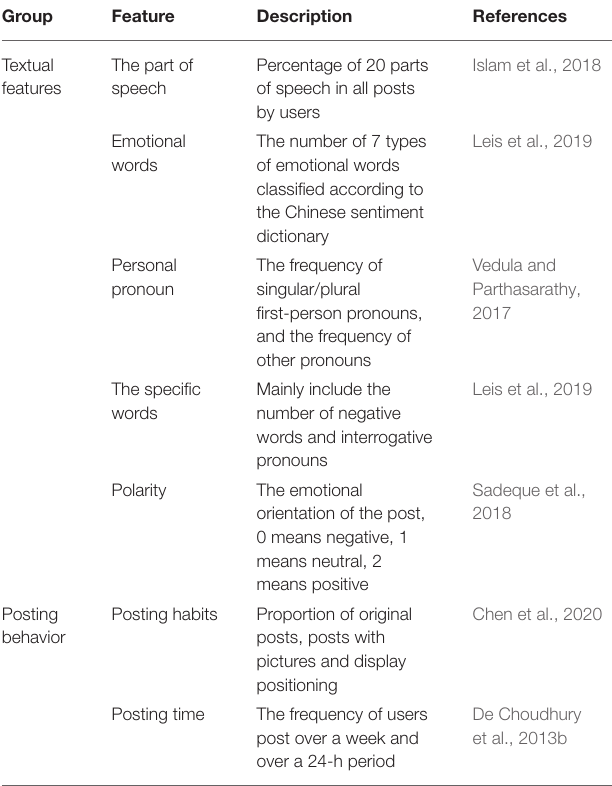
TABLE 1 | Description of user